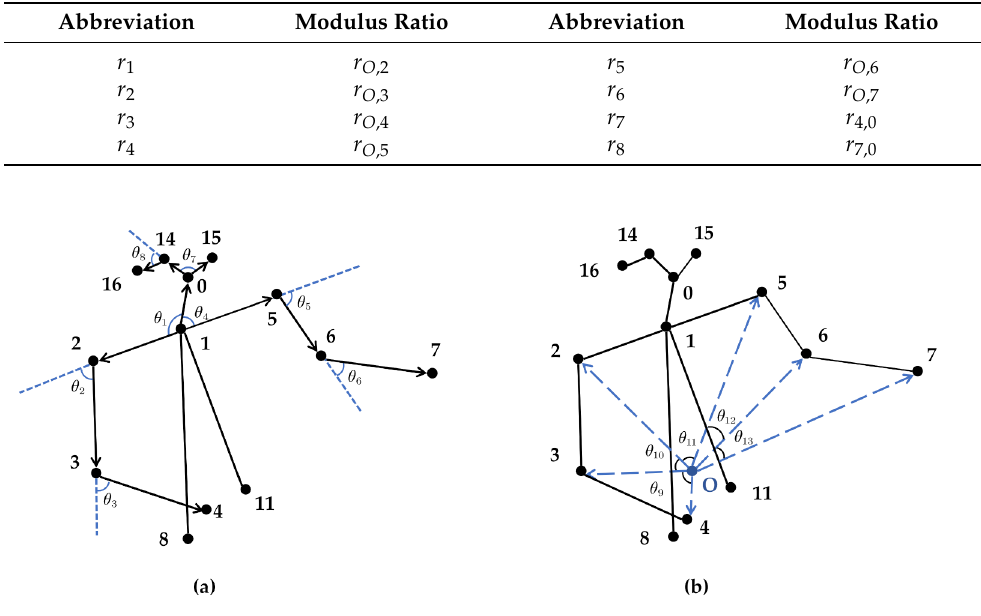
Figure 6. Vector angle of human body structure ( a , b